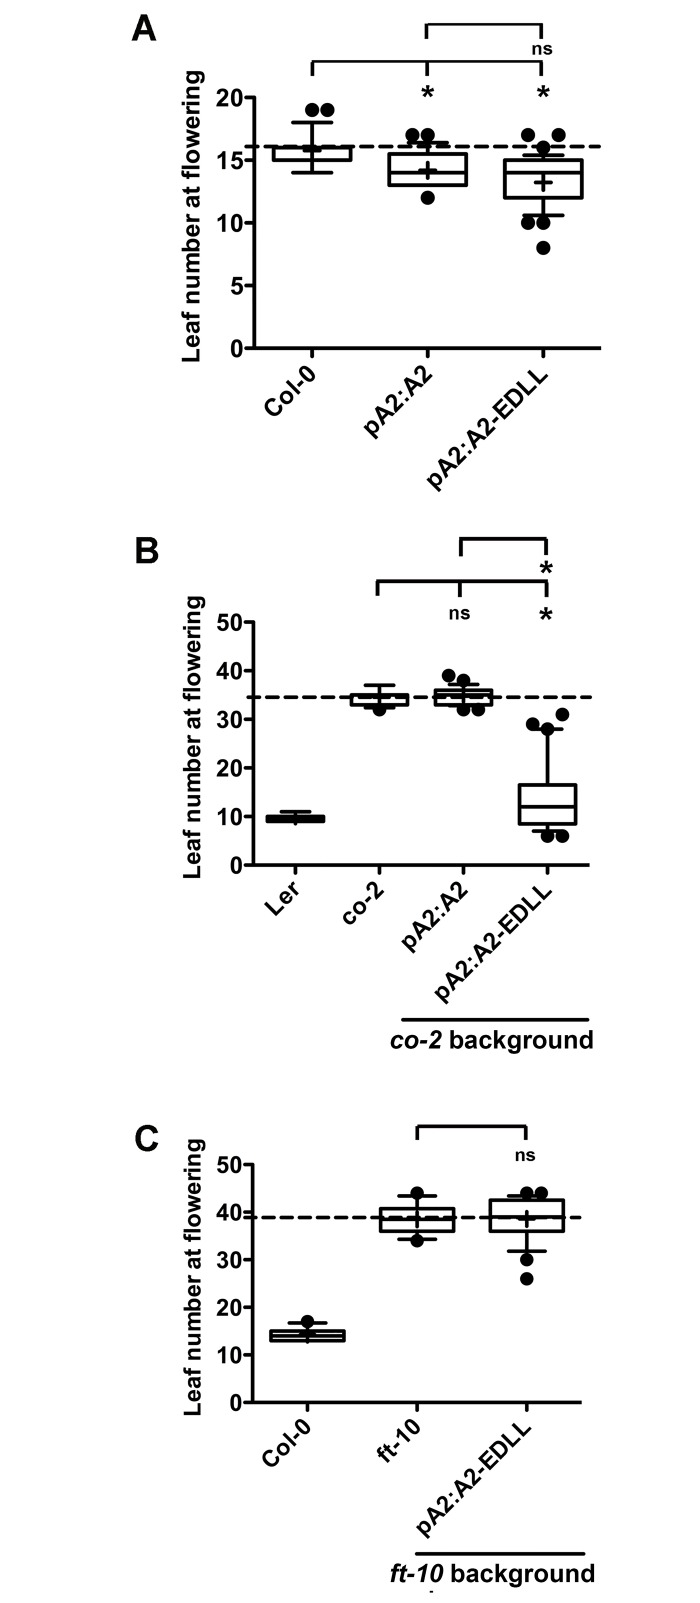
pNF-YA2:NF-YA2-EDLL can induce flowering in the absence of CO.Flowering time quantification for 15–20 randomly selected T1 plants in A) Col-0, B) co-2, and C) ft-10. Asterisks represent significant differences derived from one-way ANOVA (P < 0.05) followed by Bonferroni’s multiple comparison tests.